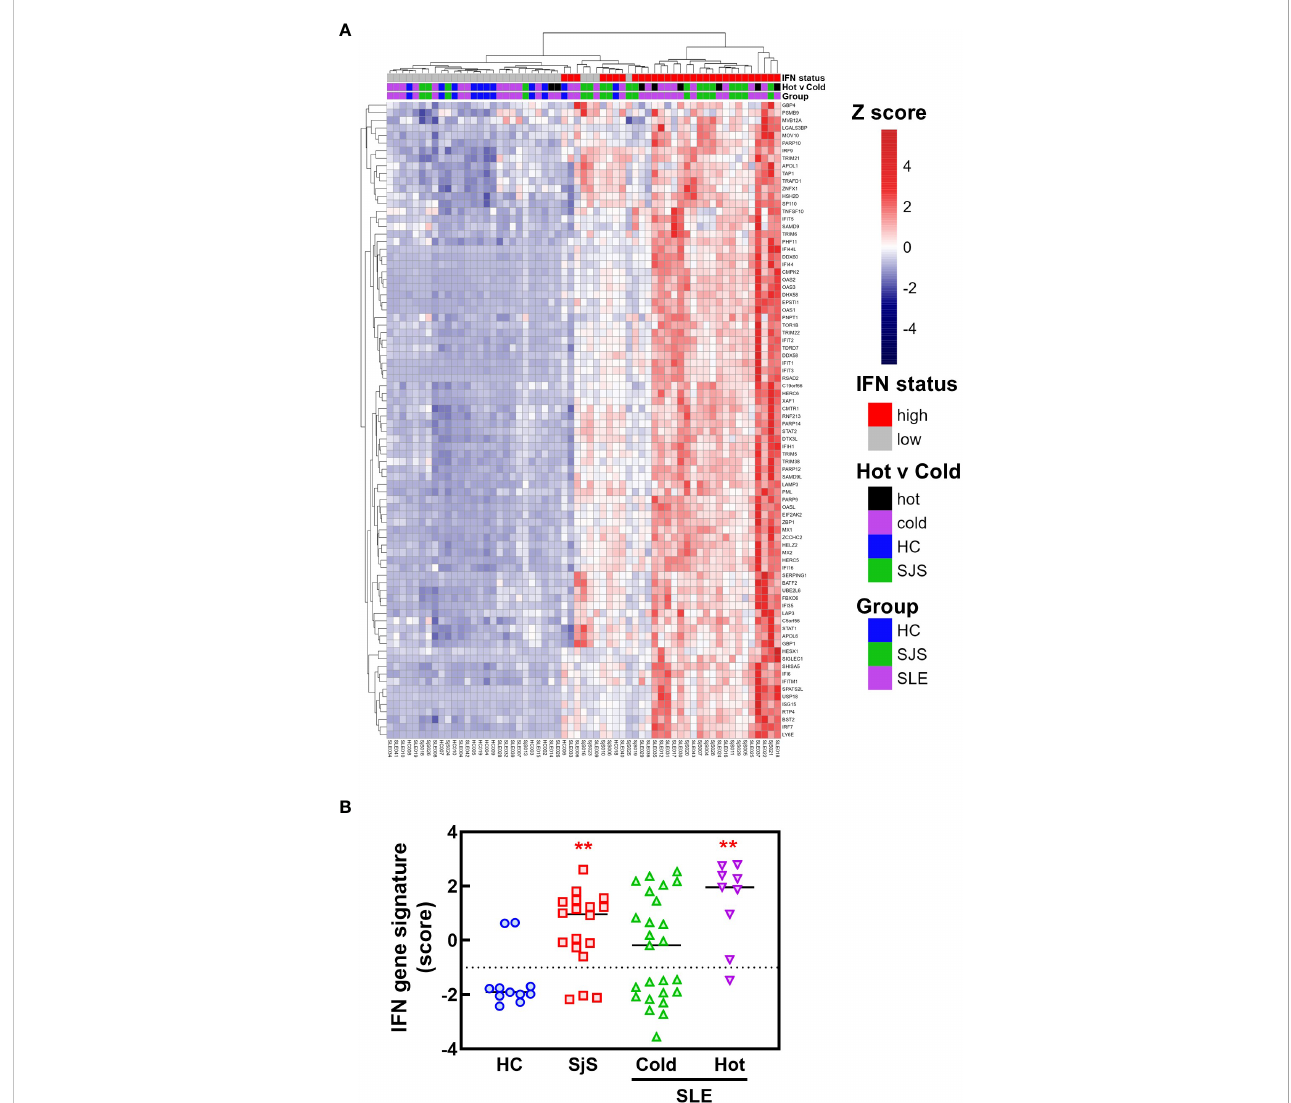
FIGURE 6 RNA-seq analysis of IFN response gene expression in SLE and SjS patients. RNA-seq analysis was performed on blood samples collected from HCs, SLE, and SjS subjects. (A) Z scores were calculated and a heat map was constructed to show the relative expression of 84 ImSig IFN pathway genes. (B) IFN gene signature scores were calculated using a panel of 9 IFN-regulated genes with the score for each subject represented by a different symbol and lines show the group medians. (**signi fi cantly different from HC ANOVA p<0.01). HCs, healthy controls; ImSig, immune cell type-speci fi c gene expression signatures; SLE, systemic lupus erythematosus; SjS, Sjogren ’ s